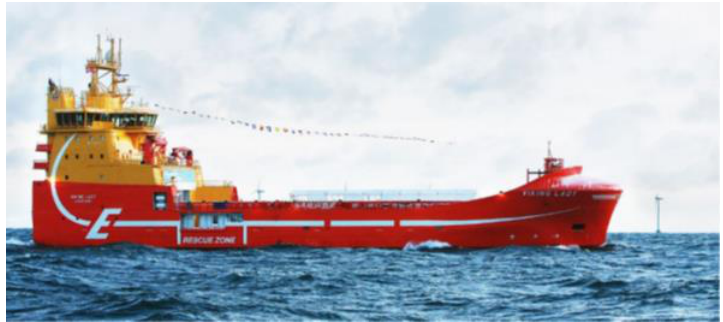
Figure 1. The offshore supply vessel Viking Lady [41].